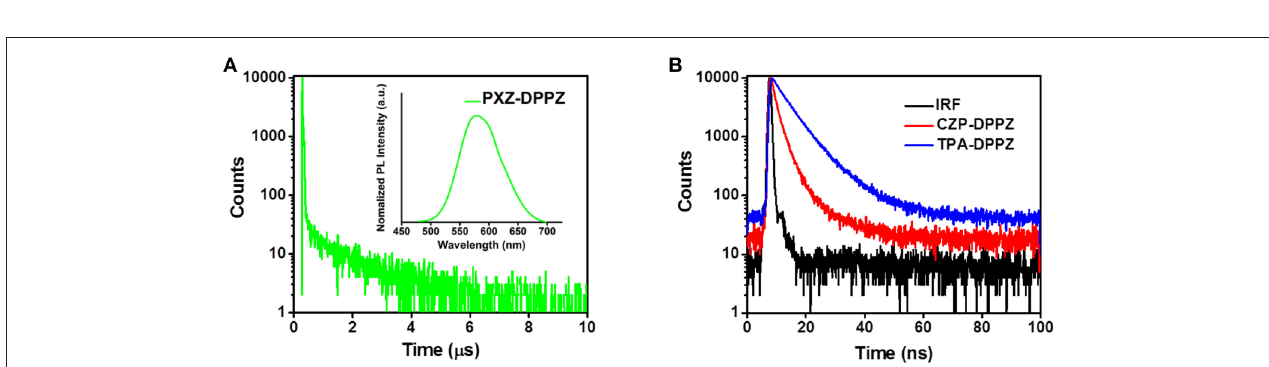
FIGURE 5 | (A) Lifetime and PL spectra of PXZ-DPPZ and (B) lifetimes of CZP-DPPZ and TPA-DPPZ in doped film.